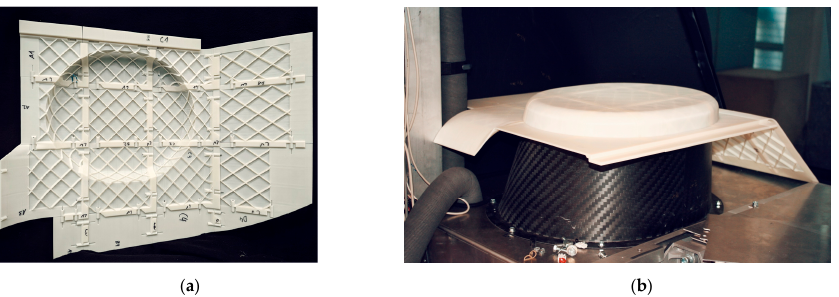
Figure 23. ( a ) Base panel of the luggage rack after manufacturing and assembly. ( b ) Placement of the final base panel into the UNICARagil autoTAXI.